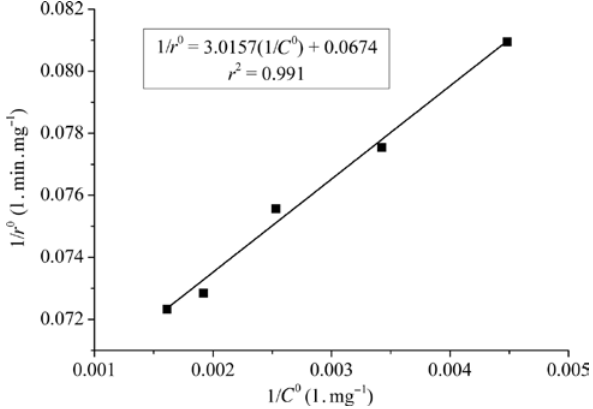
Figure 10: Langmuir–Hinshelwood kinetic model of the catalytic oxidation of DBT.